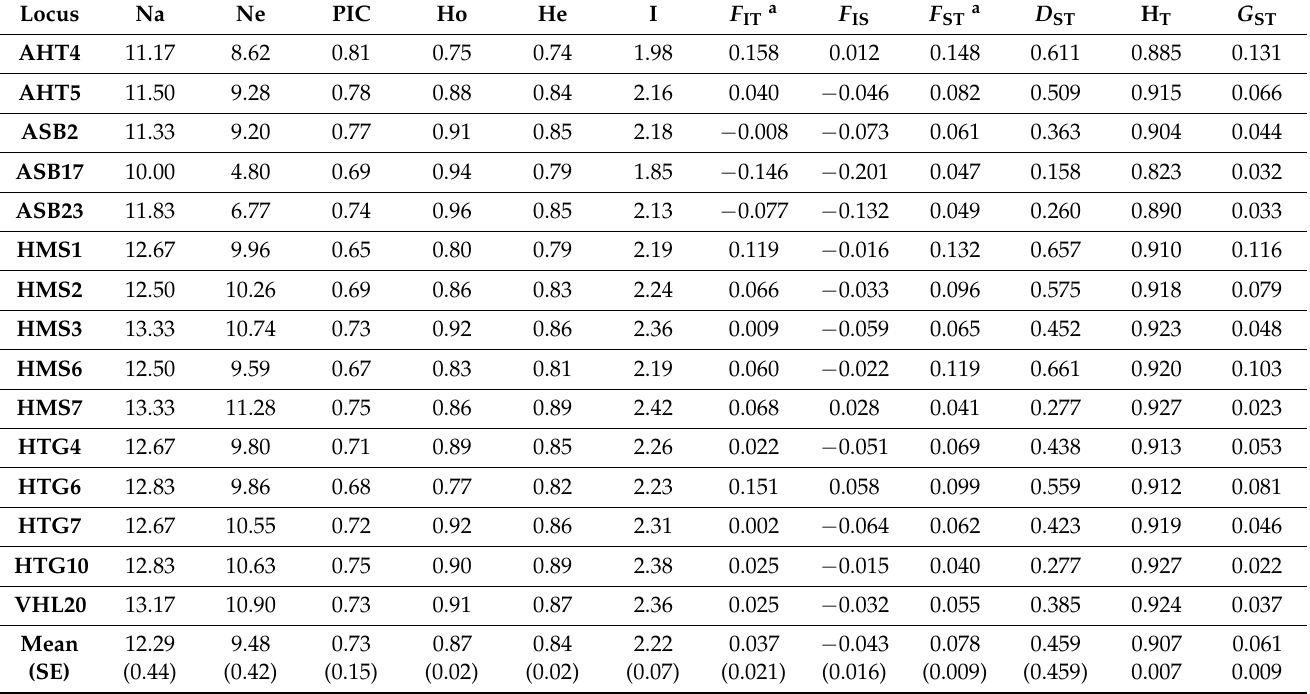
Table 2. Number of identified alleles per locus (Na), number of effective alleles (Ne), polymorphism information content (PIC), observed (Ho) and expected (He) heterozygosity, Shannon’s